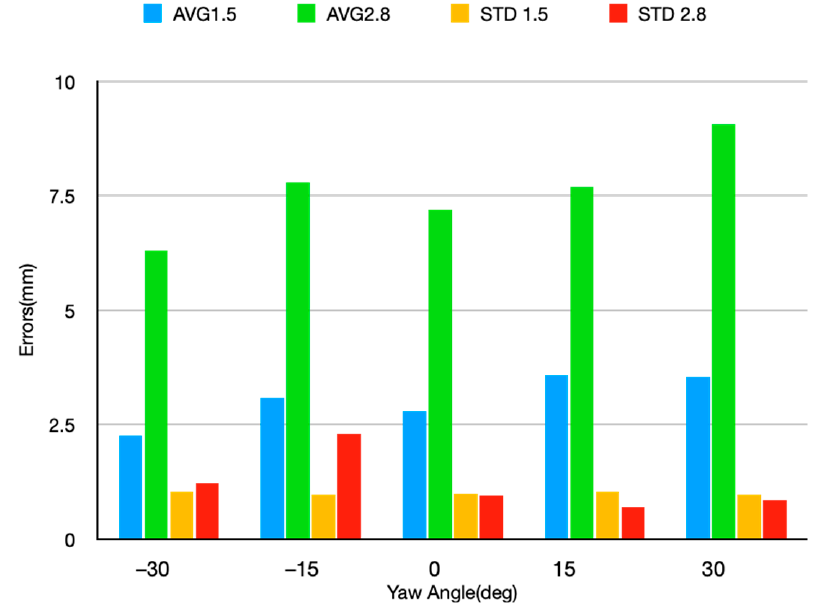
Figure 8. Comparison of depth estimation.